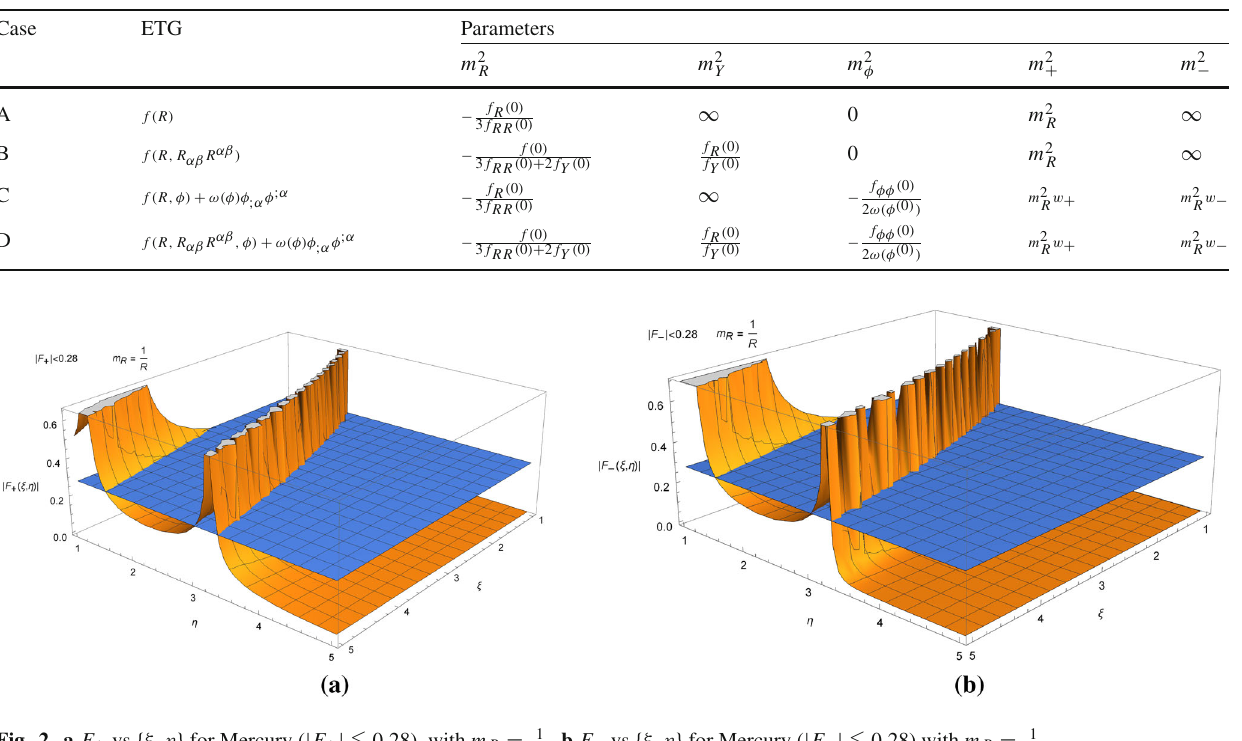
Table 1 We report different cases of Extended Theories of Gravity including a scalar field and higher-order curvature terms. The free parameters are given as effective masses with their asymptotic behavior. Here, we assume f R ( 0 , 0 , φ ( 0 ) ) = 1, ω(φ ( 0 ) ) = 1 / 2